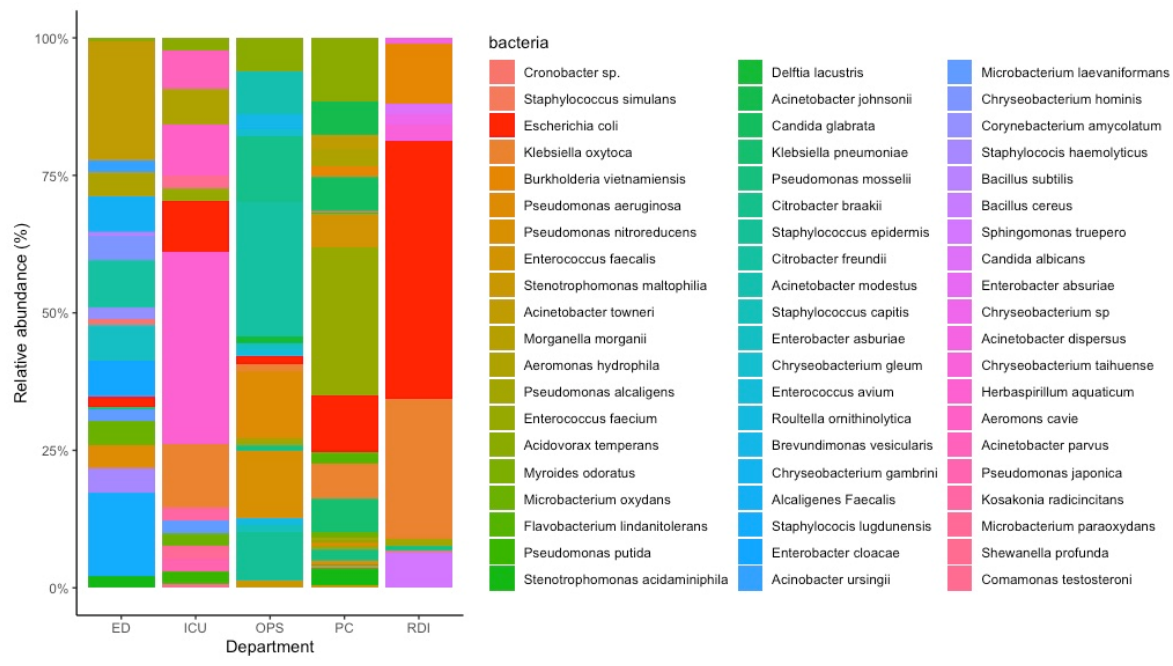
Figure 1. Isolated E. coli from wastewater from The Queen Elizabeth Hospital (TQEH). The percent stacked column bar chart indicates the relative abundance of isolated bacteria from each department in TQEH. E. coli is indicated in red. TQEH = The Queen Elizabeth Hospital; ED = Emergency De- partment, ICU = Intensive Care Unit, OPS = Orthopaedic and Plastic Surgery Ward, PC = Palliative Care and RDI = Respiratory, Dermatology and Infectious Ward.